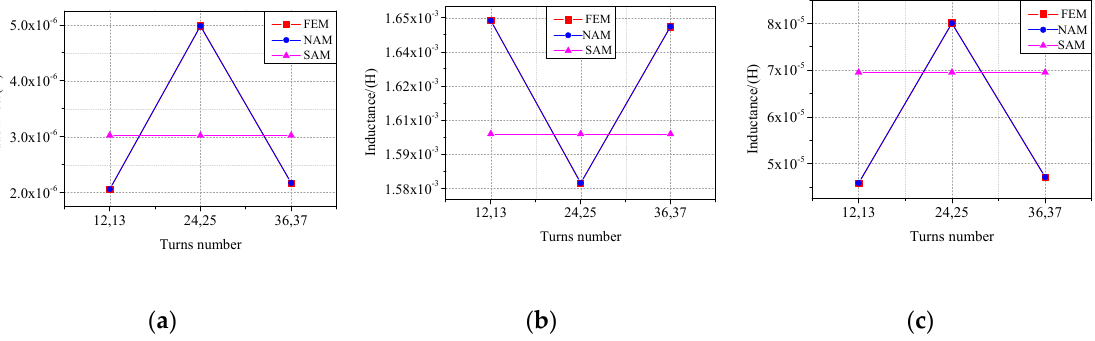
Figure 14. The inductances of the faulty coil when there are two turns shorted in different layers: ( a )